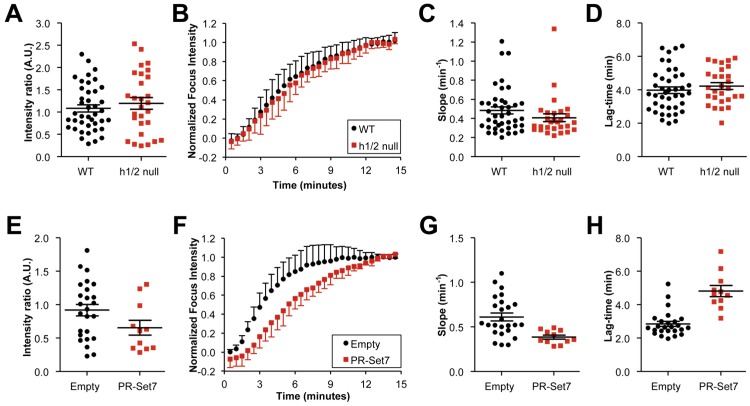
Impact of altered H4K20 methylation on recruitment kinetics of F53BP1 to MPL-induced DSBs.
A)–D) Comparison of wild type (WT) vs. Suv4-20h1/2 null (h1/2 null) MEFs. E)–H) Comparison of Suv4-20h1/2 null MEFs expressing empty retrovirus vs. PR-SET7 retrovirus. A) and E) Plot of peak fluorescence intensity for each responding cell. Note that the high proportion of non-responsive cells in PR-SET7 cultures are not represented in this analysis. Bar represents the mean peak fluorescence intensity for each data set and error bars indicate s.e.m. (A: p<0.45; E: p<0.09). B) and F) Plot of averaged mCherry-F53BP1 fluorescence accumulation over time, normalized to a peak fluorescence intensity of 1.0 for each responding cell. C) and G) Plot of slope in fluorescence accumulation at the inflection point for each cell imaged. Bar represents the mean slope and error bars indicate s.e.m. (C: p<0.18; G: p<0.0026). D) and H) Plot of lag-time in fluorescence accumulation for each cell imaged. Bar represents the mean lag-time and error bars indicate s.e.m. (D: p<0.4; H: p<0.0001).